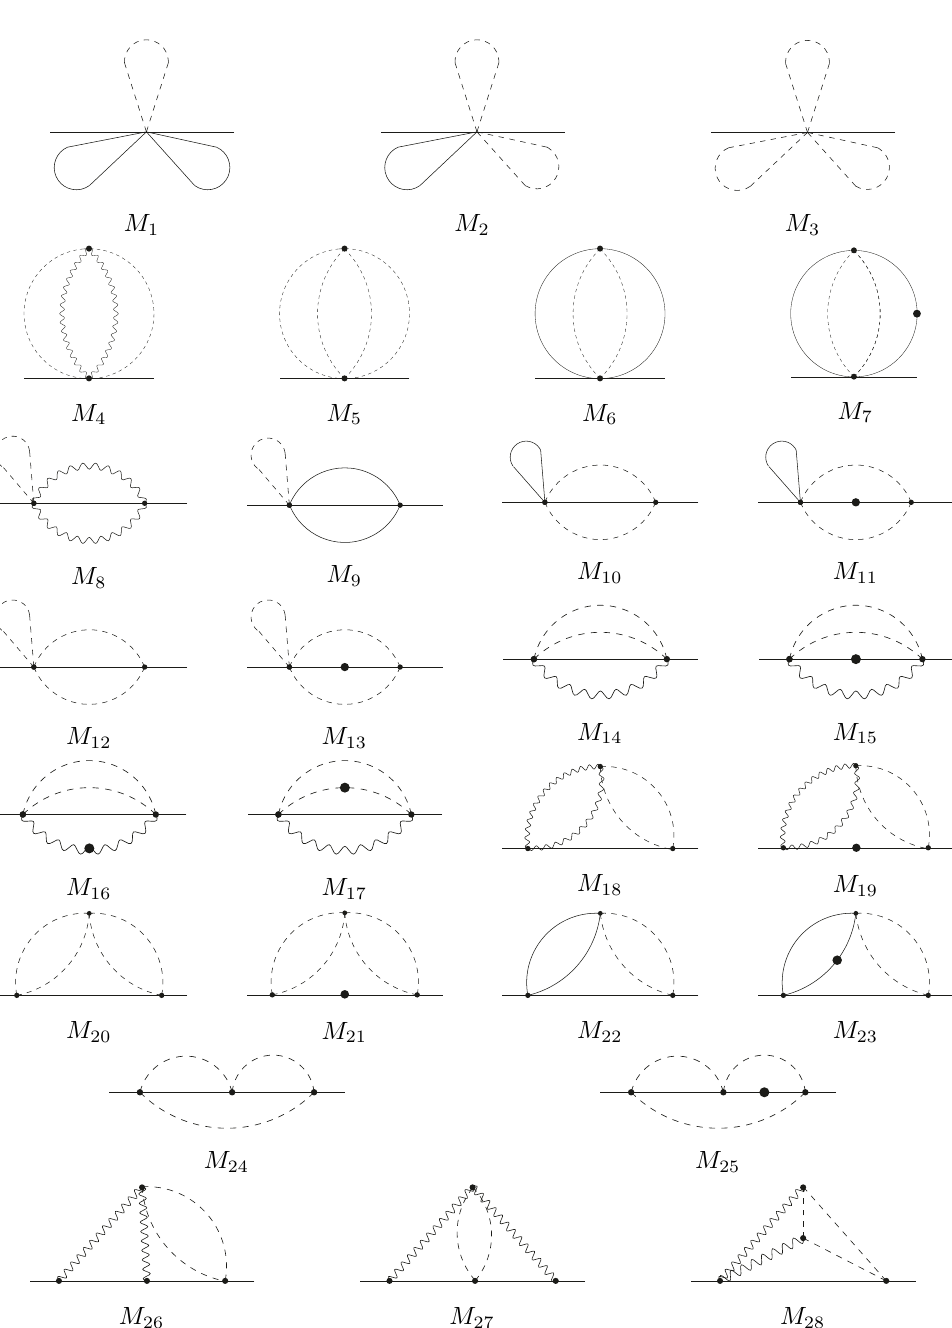
Figure 2. Three-loop master integrals after the LiteRed reduction. Solid and dashed lines repre- sent propagators with mass m 1 and m 2 . Wavy lines stand for massless particles. Note that there is a relation between M 4 , M 14 , M 15 and M 17 (see text).